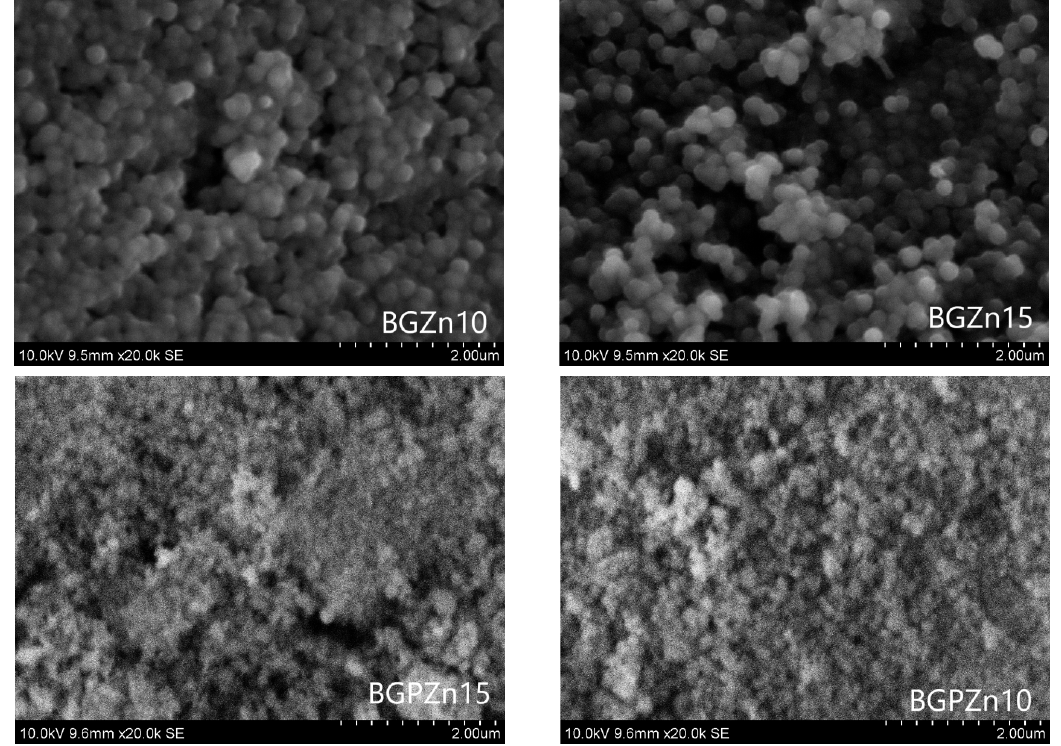
Figure 1. SEM micrographs of particles doped with Cu: BGCu, BGCu10, BGPCu15 and SiO 2 particles impregnated in a solution of copper nitrate (SiO 2 /Cu 2+ ). Table 3. EDX analysis of the samples with Cu.